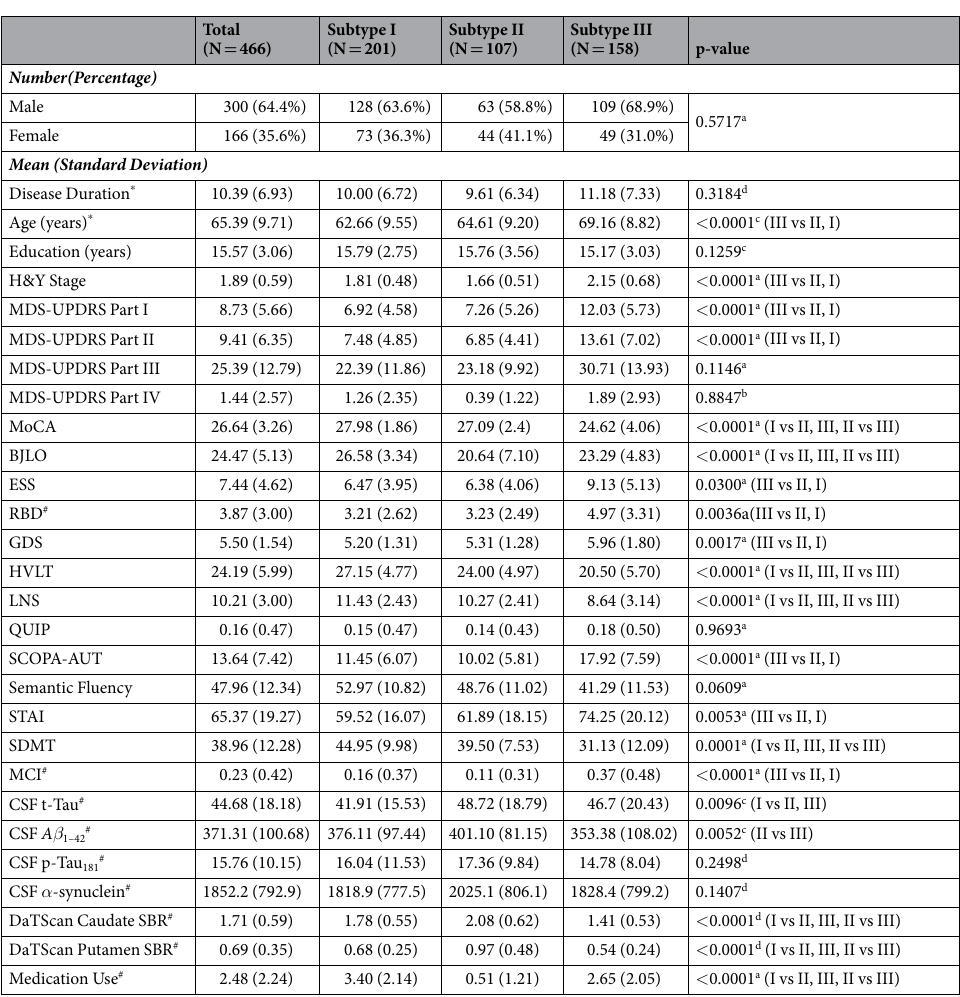
Table 2. Group characteristics of patients at their last records in the three subtypes. * Disease duration and Age are calculated based on the last time points of MDS-UPDRS. a Chi-square test; b Fisher exact test; c One-way ANOVA test; d Kruskal-Wallis H-test. The specific different subtypes Determined by use of Tukey post hoc analysis. Abbreviations: H&Y: Hoehn and Yahr; MDS-UPDRS: Movement Disorders Society–revised Unified Parkinson’s Disease Rating Scale; MoCA: Montreal Cognitive Assessment; BJLO: Benton Judgment of Line Orientation; ESS: Epworth Sleepiness Scale; RBD: Rapid eye movement sleep Behavior Disorder; GDS: Geriatric Depression Scale; HVLT: Hopkin’s Verbal Learning Test; LNS: Letter Number Sequencing; QUIP: Questionnaire for Impulsive-Compulsive Disorders in Parkinson’s Disease; SCOPA-AUT: SCales for Outcomes in PArkinson’s disease-AUTomotic symptoms; STAI: State Trait Anxiety Inventory; SDMT: Symbol Digit Modalities Test;